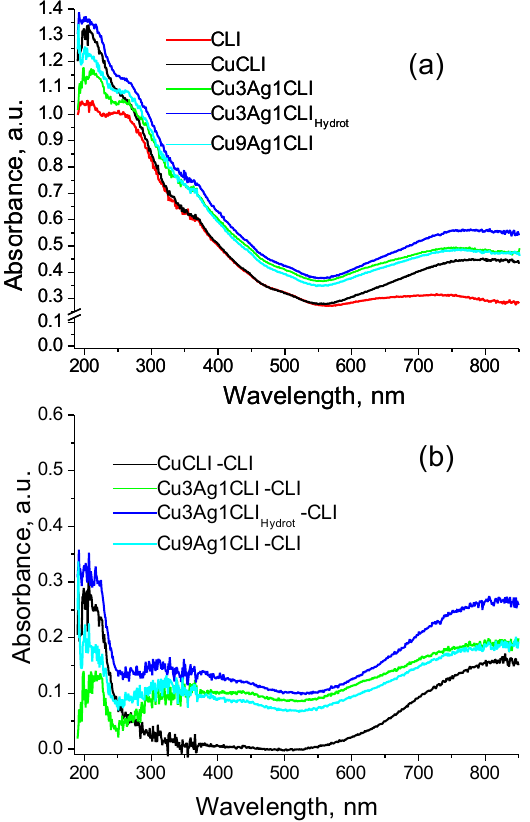
Figure 1. UV-Vis diffuse reflectance spectra of the exchanged mono- and bi-metallic samples ( a ) and subtracted spectra ( b ), showing absorption due to Cu 2+ ions only. Note that absorbance scale is different for ( a , b ).